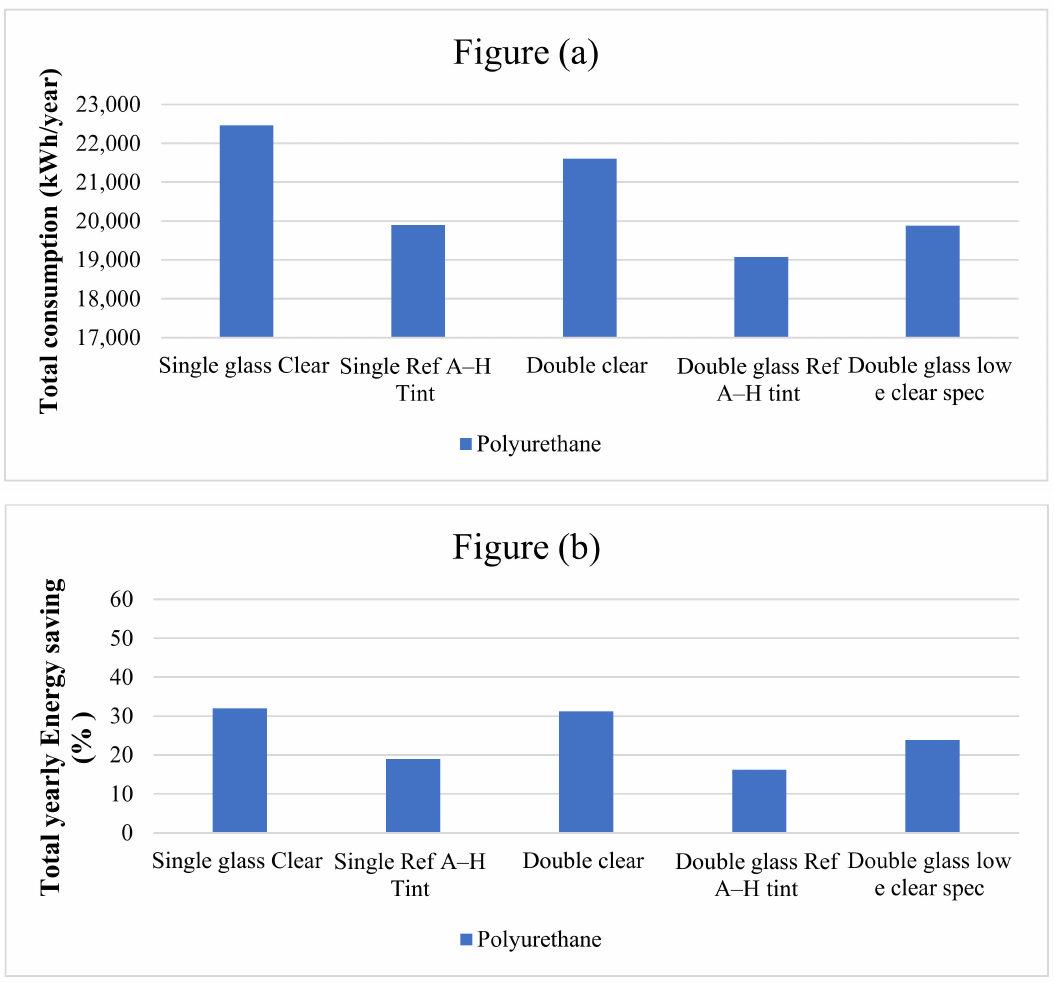
Figure 5. Effect of window shutters for different glass type on the total energy consumption of the building ( a ) and the correlated yearly total energy saving ( b ).